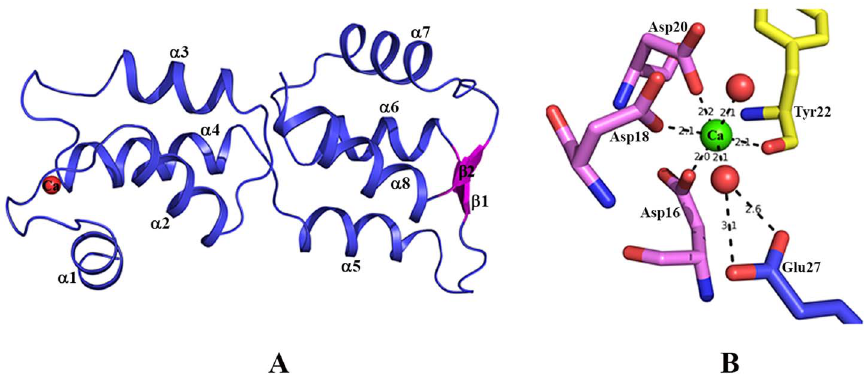
Fig 1. Structure of EhCaBP5. (A) Overall structure of Entamoeba histolytica calcium binding protein-5 (EhCaBP5) at 1.9 A˚ resolution, shown as a ribbon diagram. All of the alpha helices ( a 1 to a 8) are in blue, the small antiparallel b -sheet ( b 1 and b 2) is represented in pink, and the bound Ca 2 + is shown as a red sphere. (B) Ca 2 + coordination of EhCaBP5: The unconventional mode of Ca 2 + binding by the EF hand motif of EhCaBP5 (see text for details).